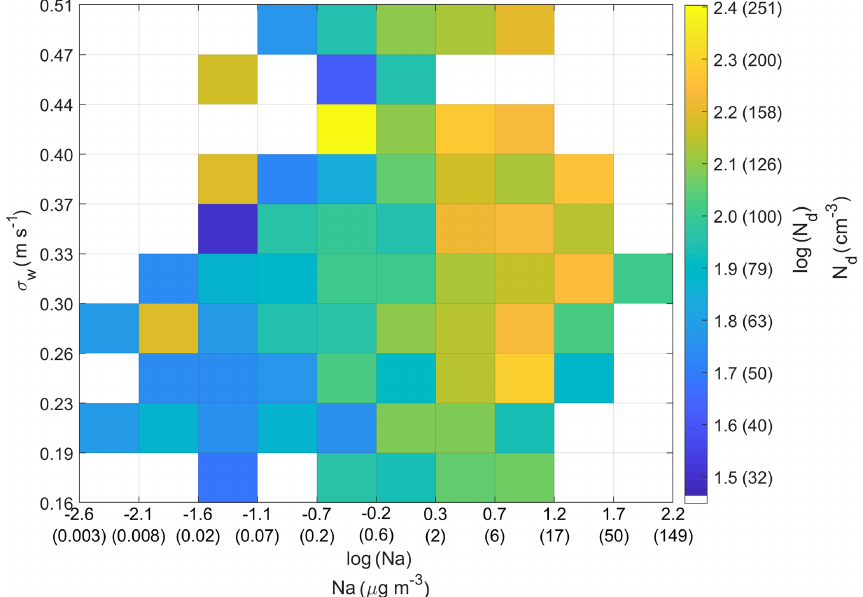
Figure 6. Heatmap showing the dependence of N d on both σ w and Na. The lower and upper bounds for the x axis, y axis, and color bar cover the entire range of σ w , Na, and N d , respectively. To assist in physical interpretation, the tick markings on the x axis and color bar show two numbers: those without parenthesis correspond to log(Na) or log( N d ) and those within parenthesis correspond to Na or N d , in their respective units.